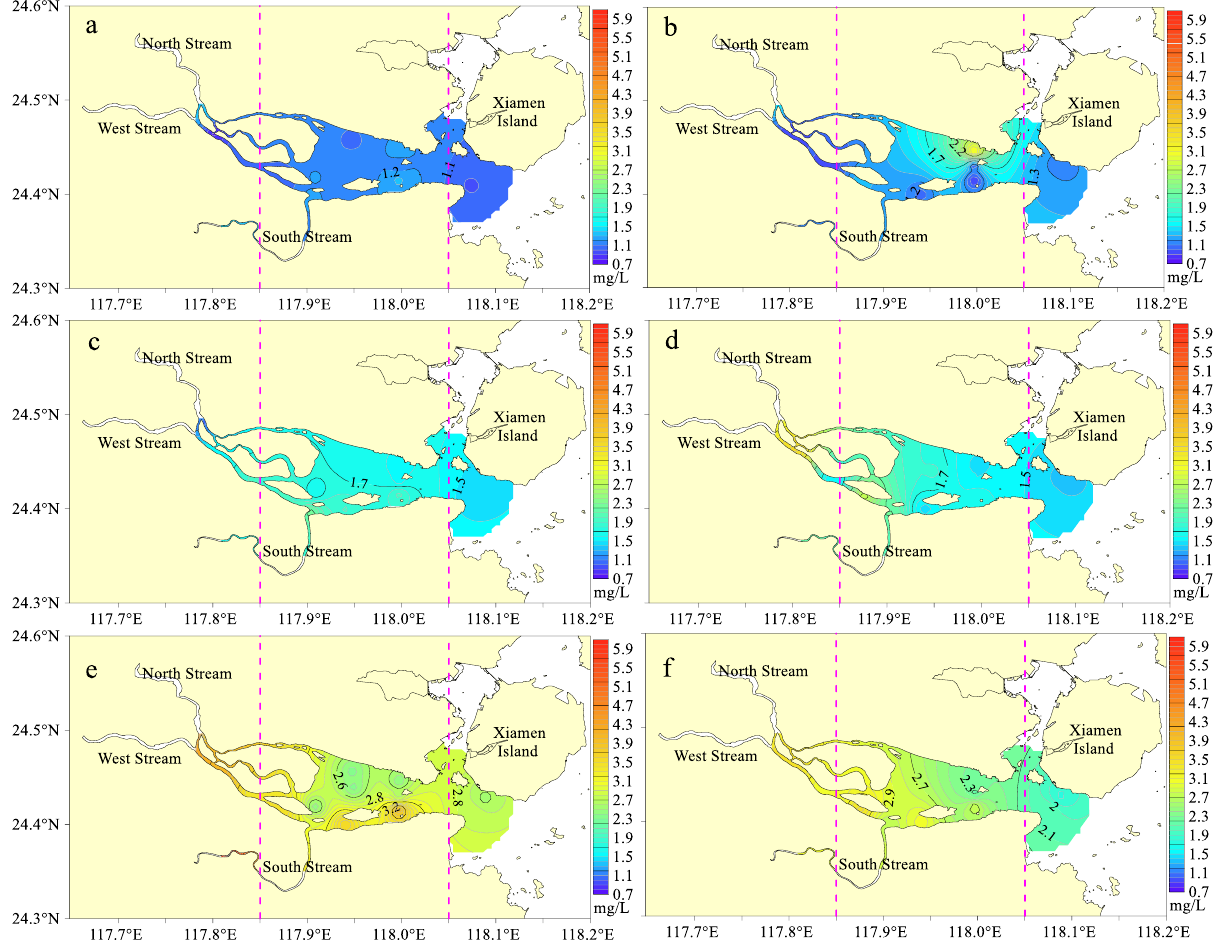
Figure 3. Horizontal distributions of TOC concentrations in the JRE. ( a ) Surface seawater in summer. ( b ) Bottom seawater in summer. ( c ) Surface seawater in autumn. ( d ) Bottom seawater in autumn. ( e ) Surface seawater in spring. ( f ) Bottom seawater in spring. These figures were created with Surfer, Version 10 (https:// www. golde nsoft ware. com/ produ cts/